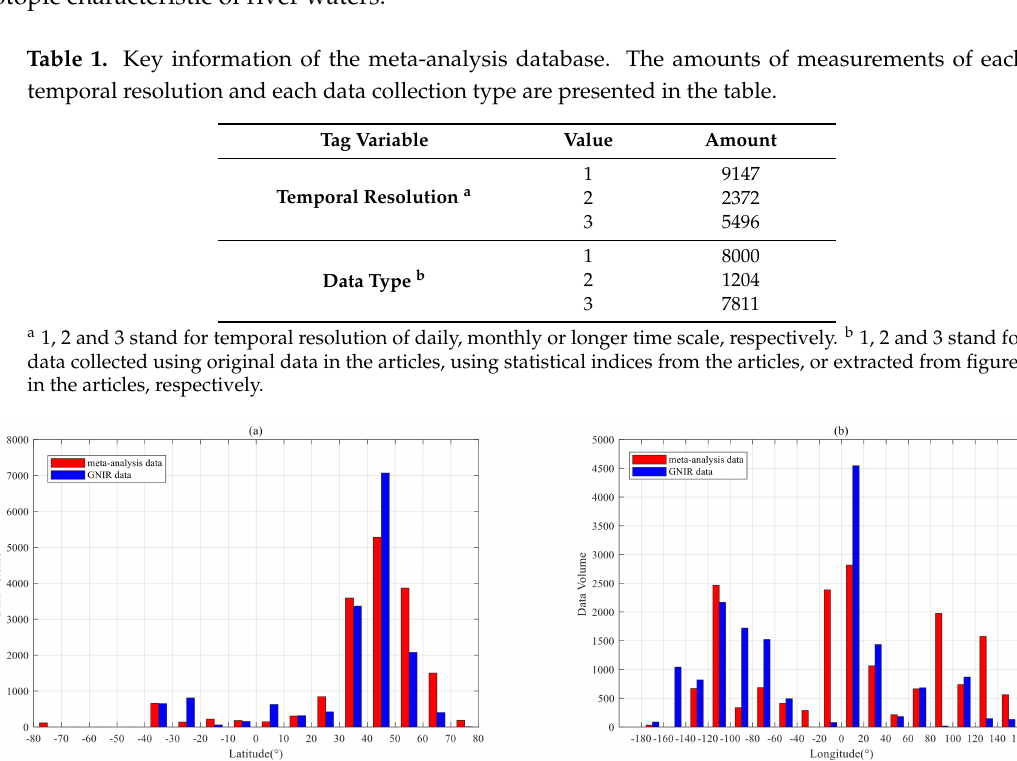
Figure 3. Data volume distribution of meta-analysis data and GNIR data along ( a ) latitude and ( b ) longitude.